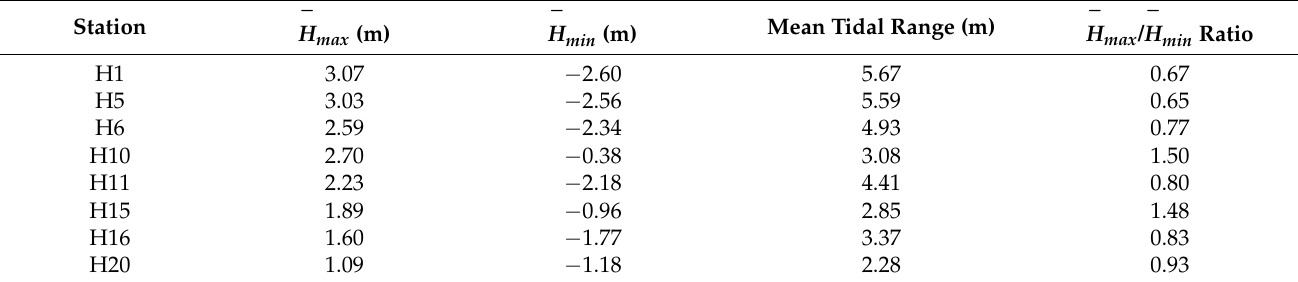
Table 3. Averaged high to low water level ratio ( H max / H min ) and the mean tide range in the year 2020. The gauge locations are given in Figure